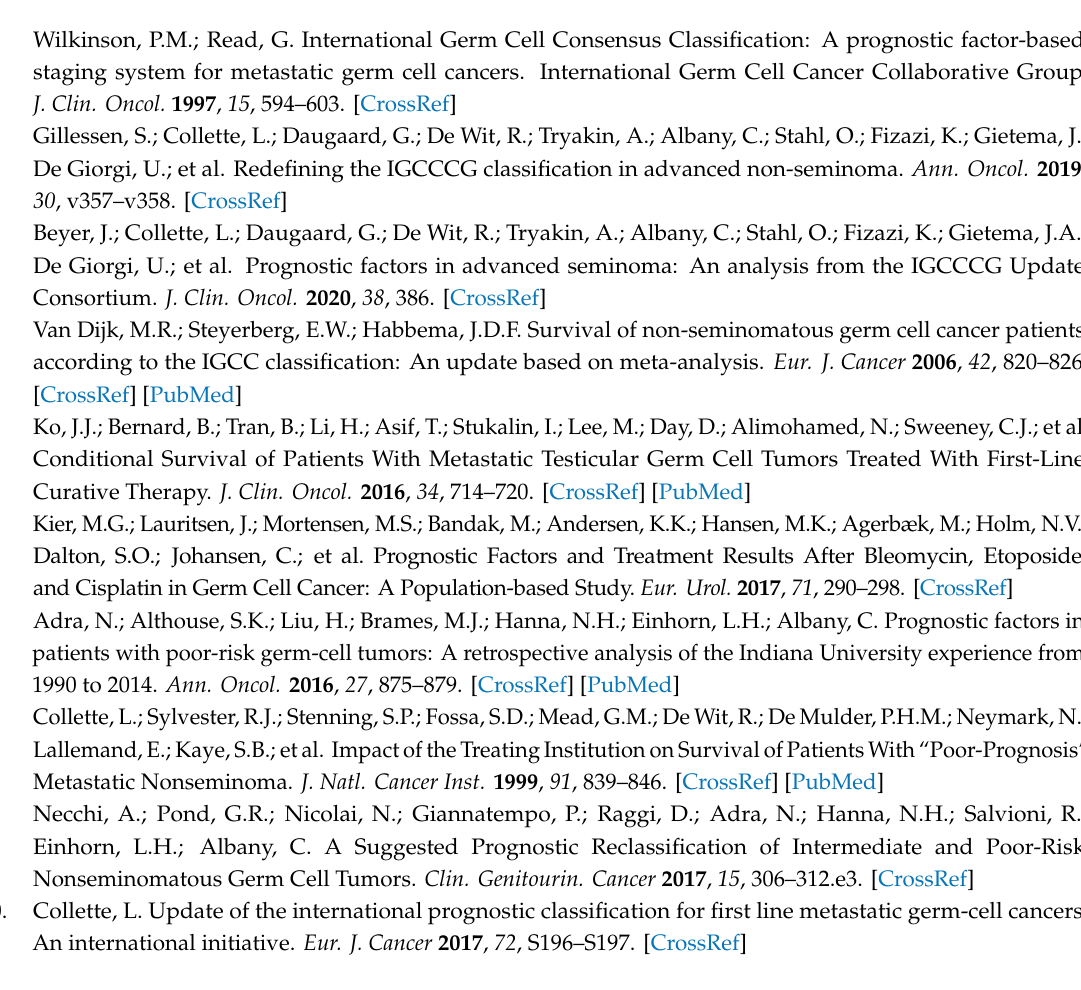
Table S1. Determination of optimal cut-o ff of NLR for PFS according to discriminatory accuracy evaluated by determining the area under the receiver operating characteristic curve (AUROC). Table S2. Determination of optimal cut-o ff of NLR for OS according to discriminatory accuracy evaluated by determining the area under the receiver operating characteristic curve